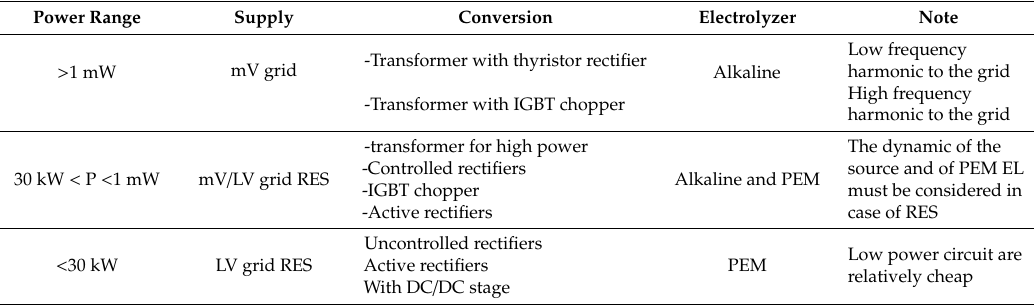
Table 5. Summary of power electronics according to the power